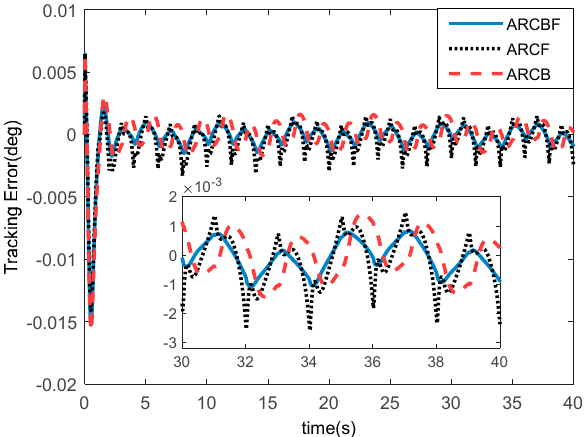
Figure 10. The compared tracking errors of the three controllers in case 2.